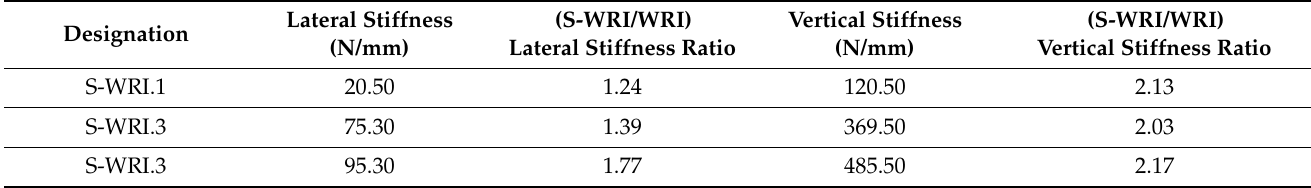
Table 4. Performance of S-WRI against WRI in terms of